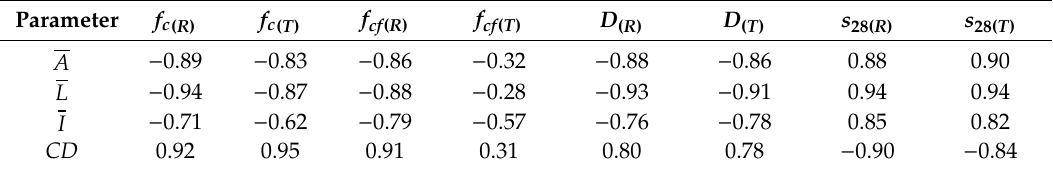
Table 6. Correlation matrix of the cement pastes